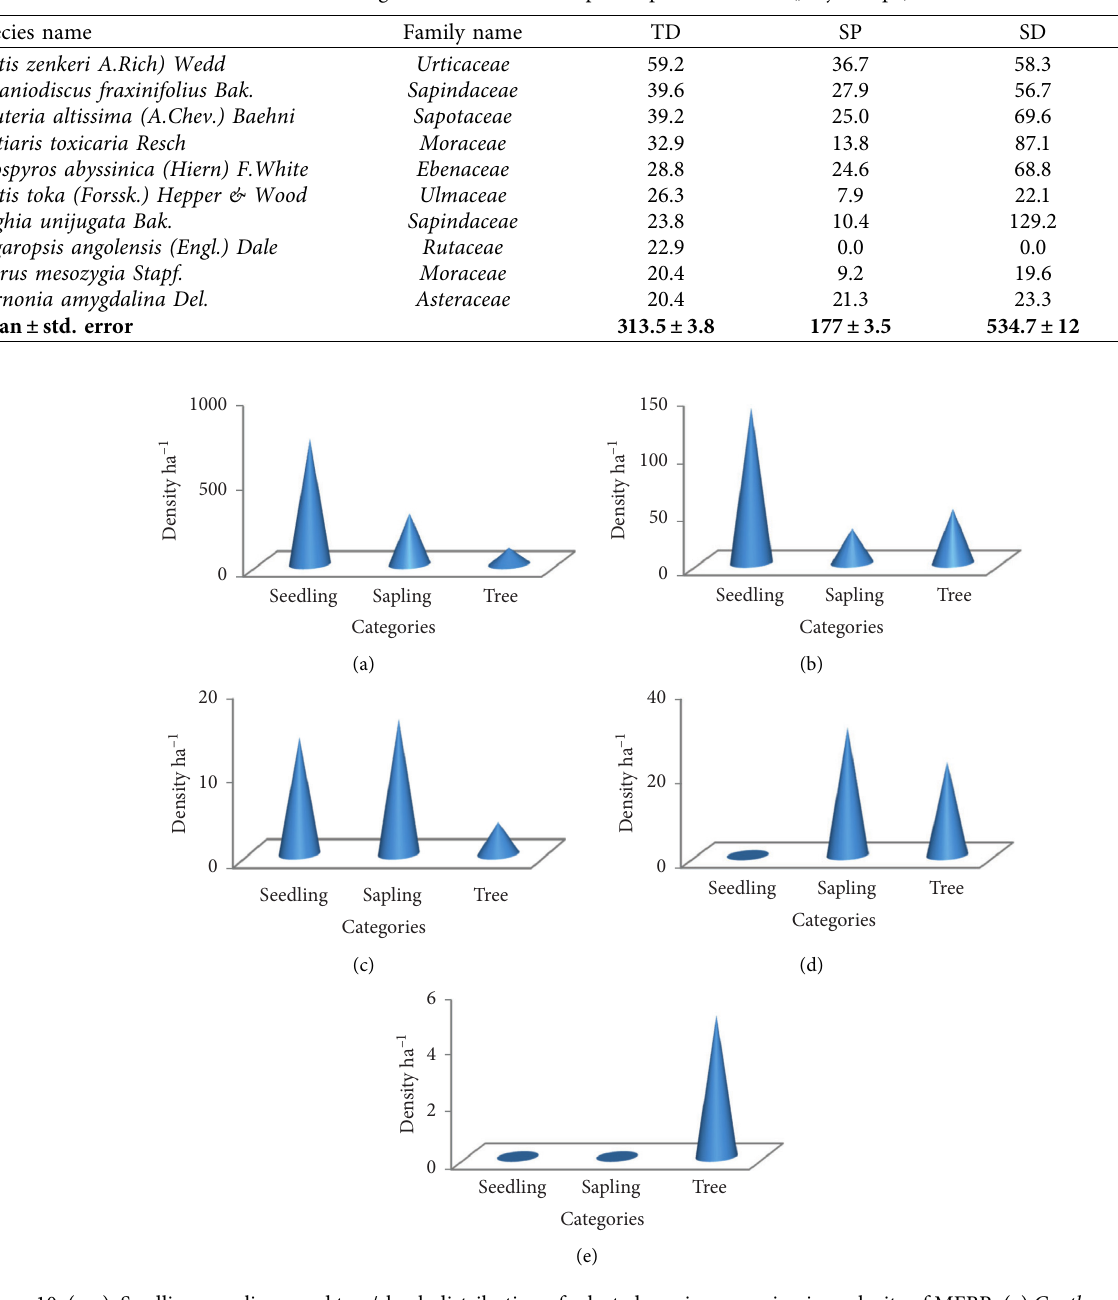
Table 11: Regeneration status of top ten species in site I